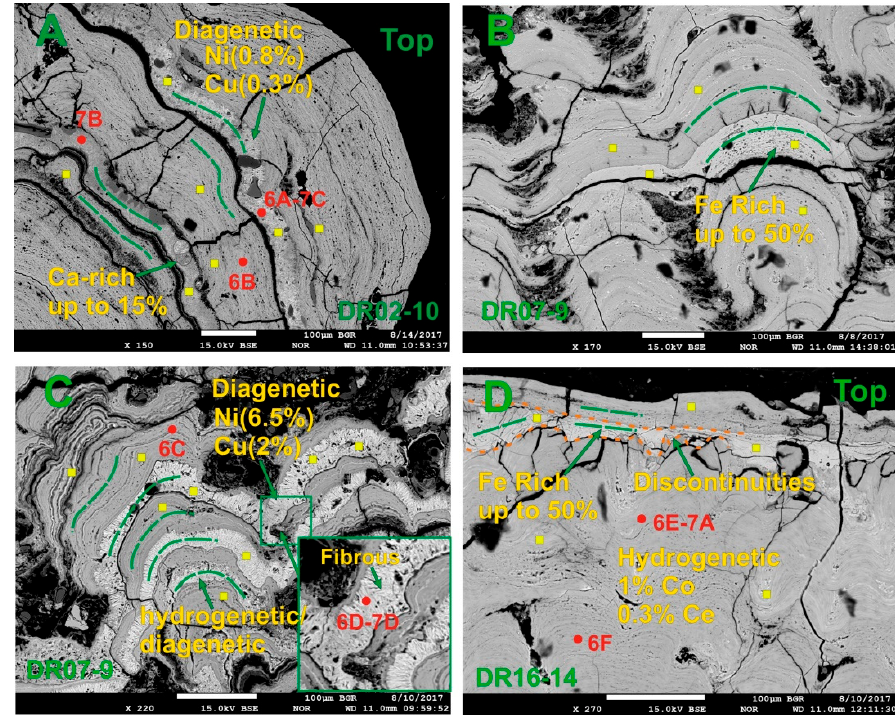
Figure 10. ( A – D ) EPMA backscattered images of this study Fe-Mn crusts. Several different laminae have been identified and analyzed with EPMA spots analyses (yellow squares) and LA-ICP-MS (discontinuous green lines). Red spots are referred to Raman and FT-IR analyses on samples in Figure 6.